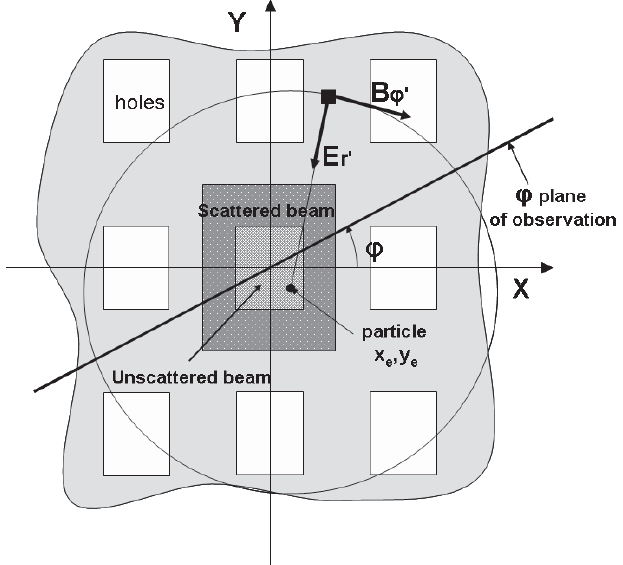
FIG. 3. Schematic of the mesh foil projected into a plane perpendicular to the z direction showing unit cell and the region of influence of the field of one electron shown by the